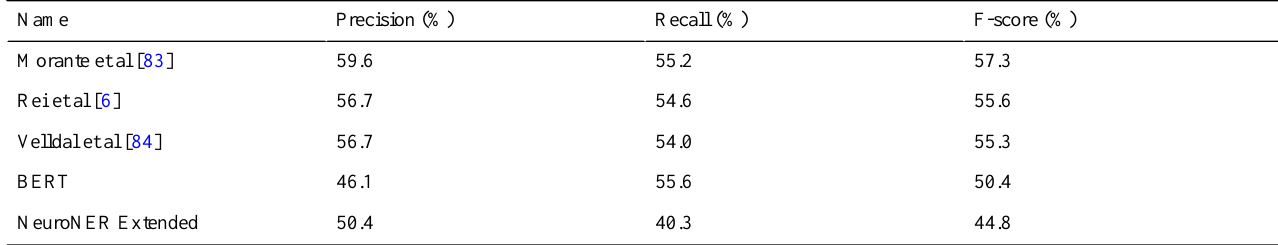
Table 20. Task 2 cue-level detection and scope determination (BioScope).